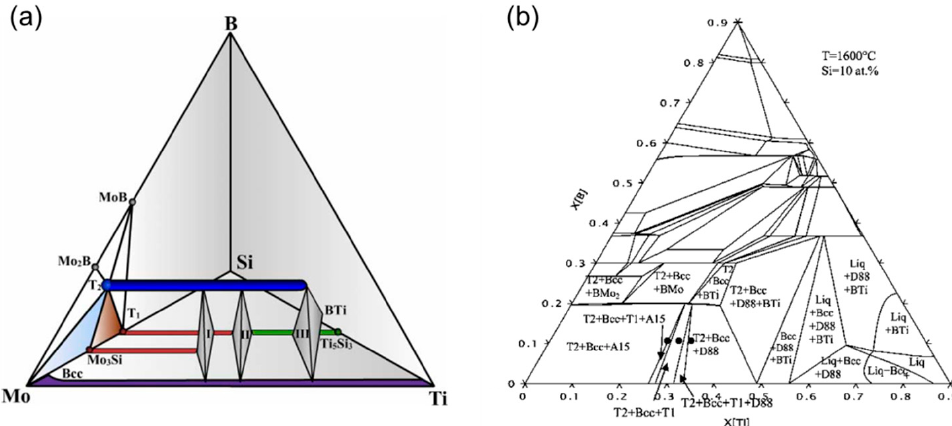
Figure 5. ( a ) Schematic isothermal tetrahedron displaying the phase relationships among BCC, T2, A15, T1 and D88 on the metal-rich side of the Mo–Ti–Si–B quaternary system at 1600 °C; ( b ) Isothermal section of Mo–Ti–Si–B at 1600 °C with Si = 10 at.% [36]. Here I, II and III represent three four-phase regions of BCC+A15+T 2 +T 1 , BCC+T 2 +T 1 +D8 8 and BCC+T 2 +D8 8 +BTi. Spaces between these regions are four different three-phase windows, i.e., A15+T 2 +T 1 and BCC+A15+T 2 on the left side of Region I, BCC+T 2 +T 1 between Region I and Region II, and BCC+T 2 +D8 8 between Region II and Re- gion III. Figure 5b [36] manifests the slice of 10 at.% Si taken from the tetrahedron in Figure 5a. The above three-phase windows, except for the A15+T 2 +T 1 that does not in-